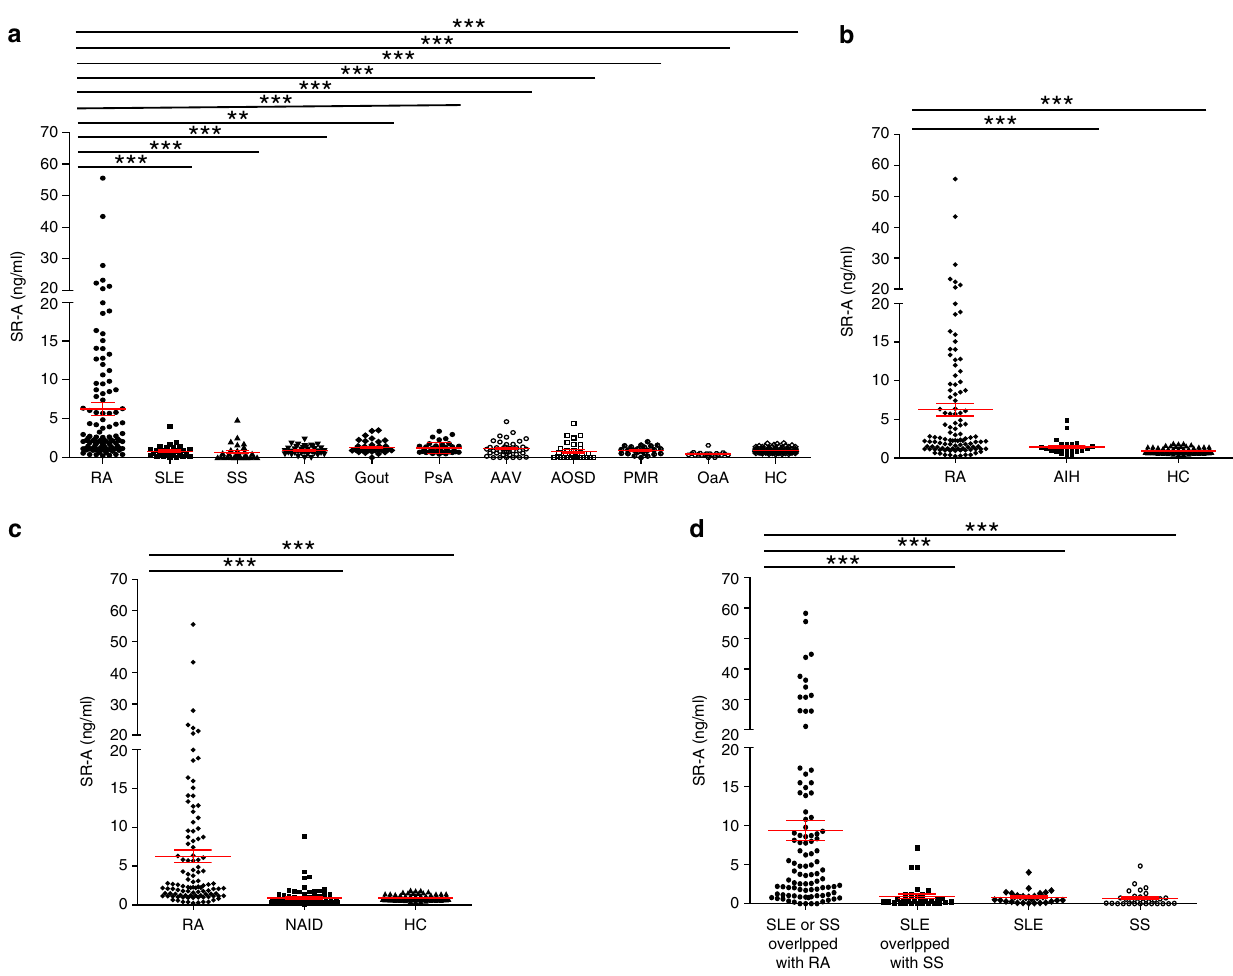
Fig. 1 The prevalence of sSR-A in patients with RA. a – c The serum levels of sSR-A were signi fi cantly higher in patients with RA than those of healthy individuals and patients with other common rheumatic diseases and non-autoimmune in fl ammatory diseases. a patients with other common rheumatic diseases (systemic lupus erythematosus (SLE, *** p = 1.1346E − 10), Sjogren ’ s Syndrome (SS, *** p < 1E − 15), ankylosing spondylitis (AS, *** p = 1.1289E − 08), Gout (** p = 0.0035), psoriatic arthritis (PsA, *** p = 1.3426E − 04), ANCA-associated vasculitis (AAV, *** p = 2.0262E − 07), adult onset still ’ s disease (AOSD, *** p = 2.98E − 13), polymyalgia rheumatic (PMR, *** p = 8.2141E − 06), and osteoarthritis (OA, *** p = 2E − 15)) and healthy controls (*** p = 4E − 15); b patients with autoimmune hepatitis (AIH, *** p = 7.8003E − 04) and healthy controls (*** p < 1E − 15); c patients with non-autoimmune in fl ammatory diseases (NAID, including enteritis, gastritis, pneumonia, and colitis, *** p < 1E − 15) and healthy controls (*** p = 3.8E − 14). d sSR-A were higher in SLE or SS overlapped with RA patients than SLE overlapped with SS patients (*** p = 9.8292E − 10), SLE patients (*** p = 3.1014E − 07) and SS patients (*** p = 1.9579E − 11). RA = 107; SLE = 30; SS = 30; AS = 39; Gout = 39; PsA = 39; AAV = 39; AOSD = 30; PMR = 24; OA = 20; HC = 90; AIH = 25; NAID = 71; SLE or SS overlapped with RA = 98; SLE overlapped with SS = 31. Red horizontal lines: means; error bars: SEMs. ** p < 0.01, *** p < 0.001 (Kruskal – Wallis test followed by Dunn ’ s posttest for multiple comparisons). Source data are provided as a Source Data fi